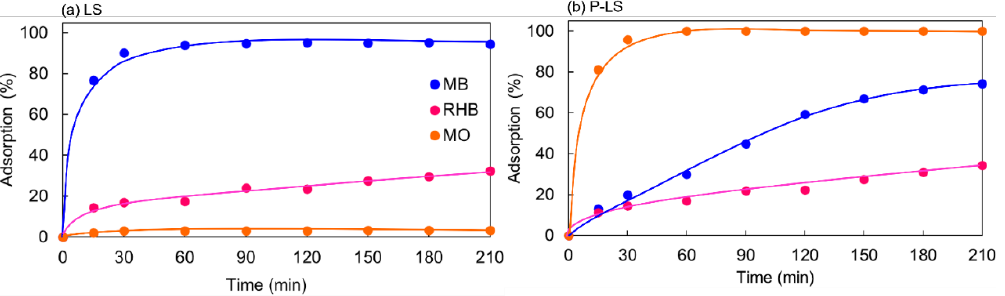
Figure 11. Adsorption capability of both LS ( a ) and P-LS ( b ) towards RHB, MB, and MO in mixture.